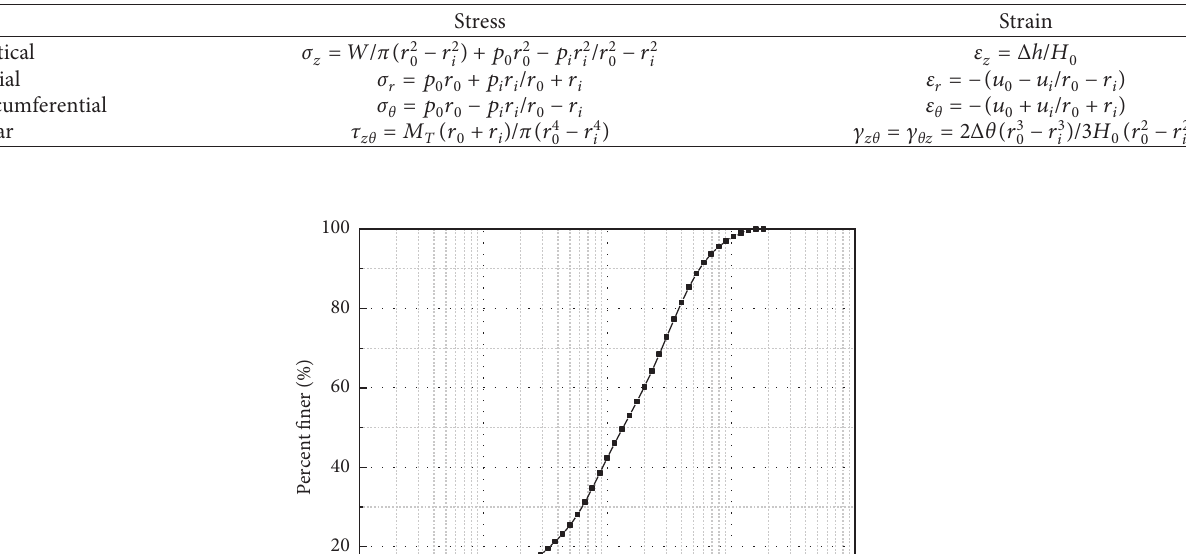
Figure 1: Schematic diagram of the structure of frozen hollow cylinder apparatus. Table 1: Equations of relation between test load parameters and stress components.